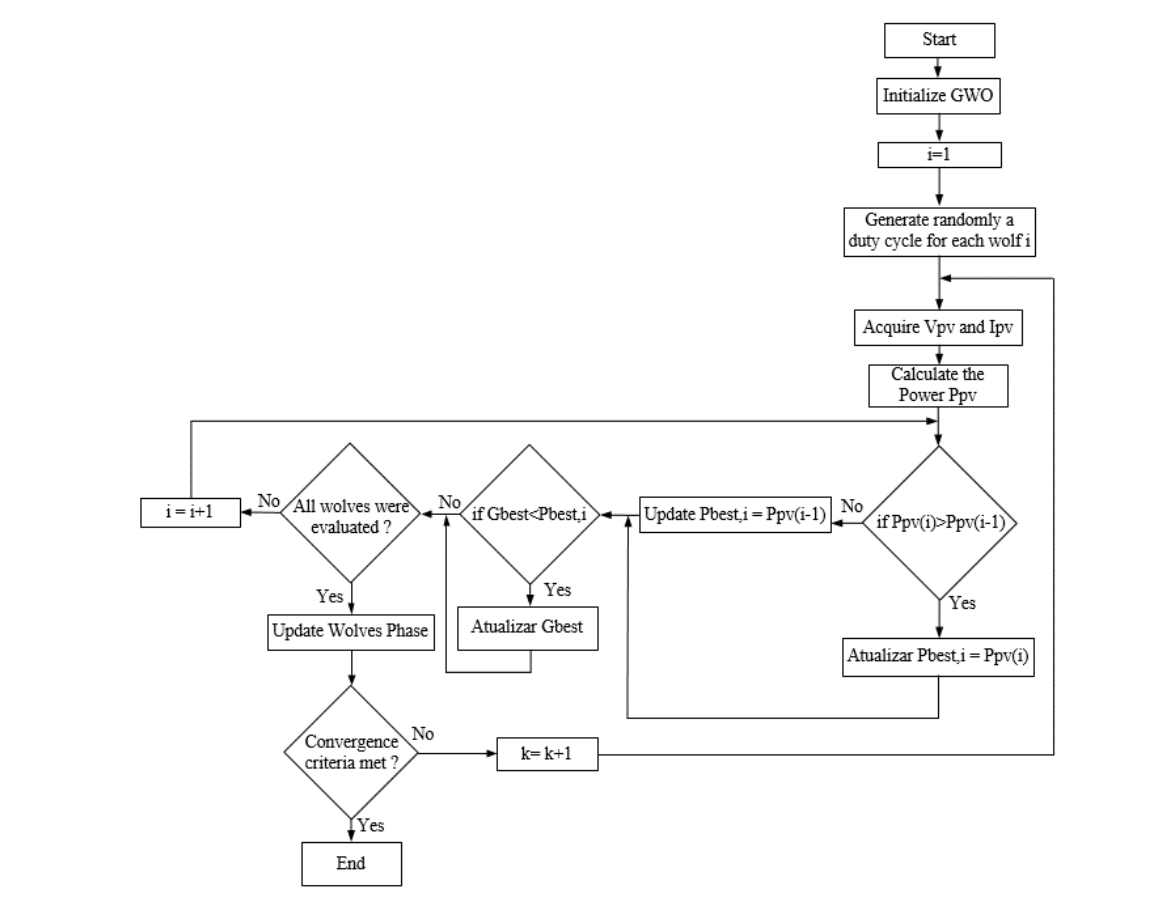
Figure 9. GWO flowchart diagram.